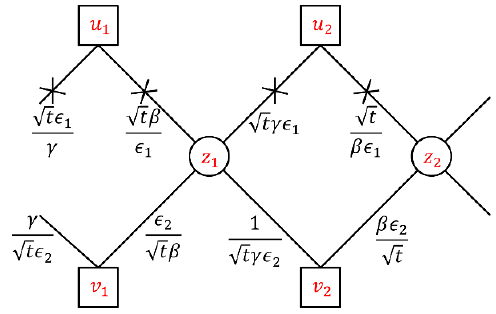
Figure 23 . The trinion with three maximal punctures. Here depicted is the case of k = 2. detailed in appendix D. For the odd k case the anomalies computed from (cid:12)eld theory